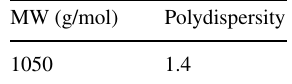
Table 2 Molecular weight and